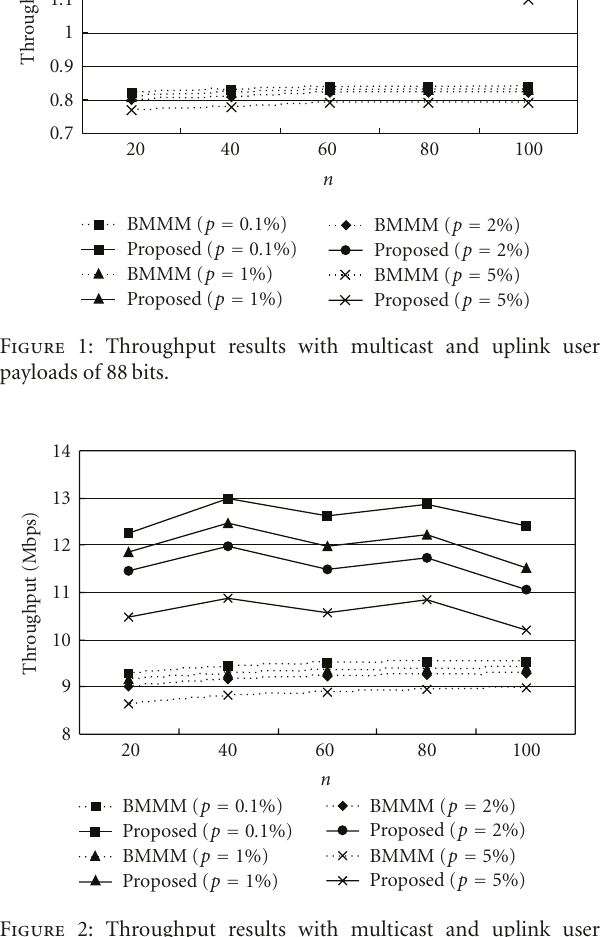
Figure 2: Throughput results with multicast and uplink user payloads of 1000